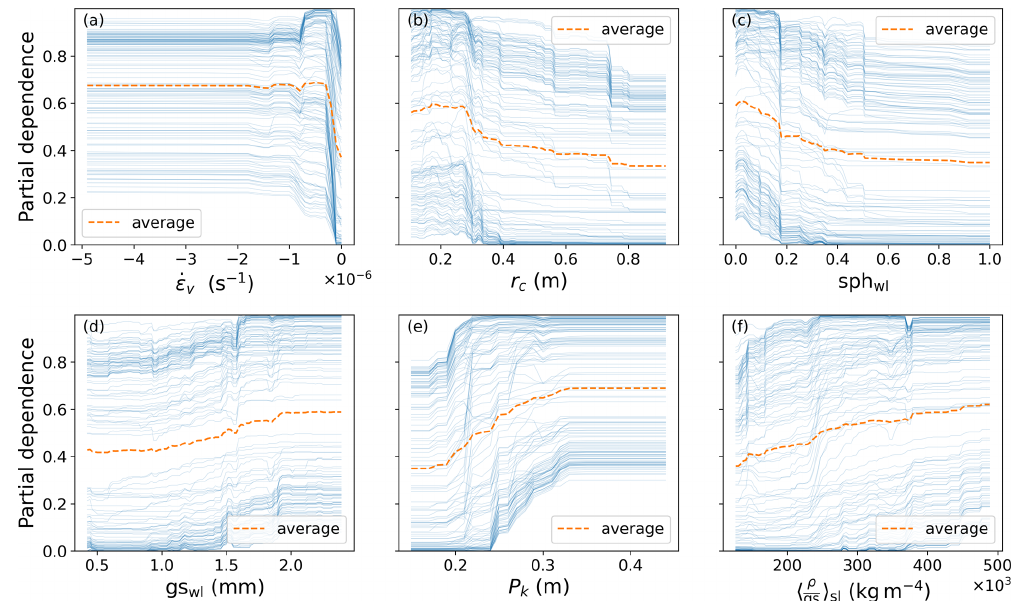
Figure B2. Partial dependence (PD) plots showing the relationship between target response and individual input features ( a viscous defor- mation rate, b critical cut length, c sphericity of the weak layer, d grain size of the weak layer, e skier penetration depth, f mean of the ratio of density and grain size of the slab). Each plot depicts how a given feature influences the predicted outcome when marginalizing over the distributions of all other features. The values for each PD plot were computed by applying the RF model to all data points of the training data set and then varying the value of the feature of interest while keeping the values of all other features fixed. The blue lines show the target response for the individual samples, and the orange line displays the mean of all